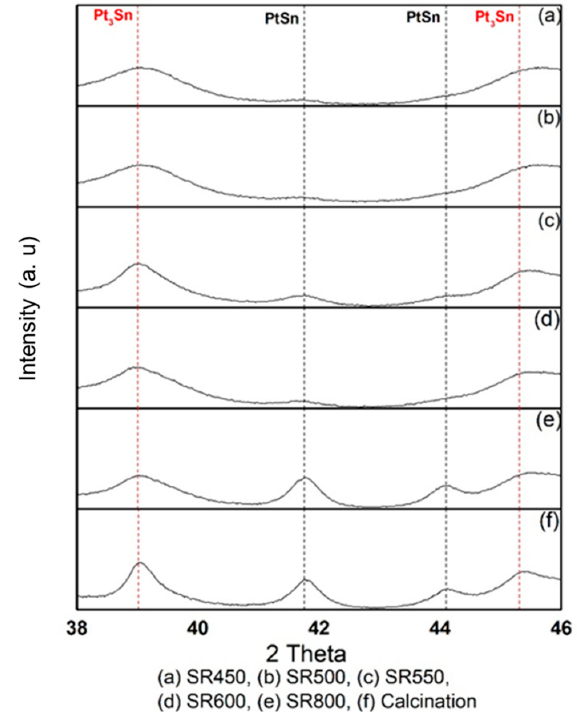
Figure 3. XRD patterns of Pt–Sn/Al 2 O 3 catalysts after catalyst preparation.